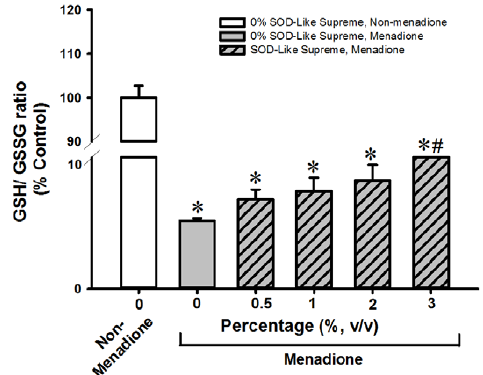
Figure 3. Effects of SOD-Like Supreme on cellular GSH/GSSG ratio in H9c2 cells following menadione challenge. After co-incubation of H9c2 cells with SOD-Like Supreme and menadione, cellular GSH/GSSG ratios were measured, as described in Materials and Methods. The GSH/GSSG ratio of the non-menadione controls is 38.4 ± 1.1 (mean ± SD). Data are expressed as % of the non-menadione controls by normalizing relative to the value of the non-menadione-incubated cells. Values given are means ± SD, with n = 4. * Significantly different from the non-menadione controls; # Significantly different from the menadione control group.